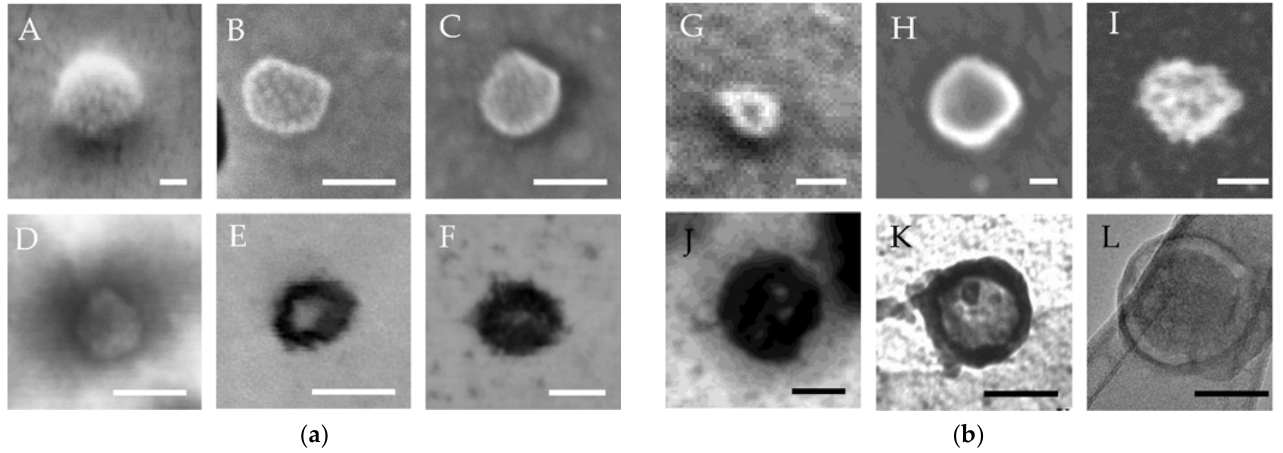
Figure 2. Electron microscopy of EV-like nanoparticles in native CSF ( a ) and EVs isolated by SEC ( b ), imaged in different modes. ( A ): sample fixed with PFA, on Si-wafer, air dried, tilted stage at 45°, SE; ( B ): sample fixed with GA, on polycarbonate membrane, air dried, SE; ( C ): sample fixed with GA, on polycarbonate membrane, dehydrated in ethanol gradient and critical point dried, SE; ( D ): sample fixed with GA, on carbon-formvar grid, uranyl acetate contrasted, air dried, STEM-BF; ( E ): sample fixed with GA, on carbon-formvar grid, Uranyless contrasted, air dried, STEM-BF; ( F ): sample fixed with GA, on carbon-formvar grid, UA-zero contrasted, air dried, STEM-BF; ( G ): sample fixed with PFA, on Si-wafer, air dried, tilted stage at 45°, SE; ( H ): sample fixed with GA, on polycarbonate membrane, dehydrated in ethanol gradient and critical point dried, SE; ( I ): sample fixed with PFA, on carbon-formvar grid, uranyl acetate contrasted, air dried, STEM-DF; ( J ): sample fixed with PFA, on carbon-formvar grid, uranyl acetate contrasted, air dried, STEM-BF; ( K ): sample fixed with PFA, on carbon-formvar grid, uranyl acetate contrasted, air dried, TEM-BF at 120 kV; ( L ): sample fixed with GA, on lacey carbon grid, dehydrated in ethanol gradient and critical point dried, TEM-BF at 200 kV. ( A , G , I , J ): Supra Zeiss 40 (Carl Zeiss AG, Oberkochen, Germany); ( B – F ): JSM 7800F (JEOL Ltd., Tokyo, Japan); ( H ): JSM 7600F (JEOL); ( K ): JEM 1200 EXII (JEOL); ( L ): JEM 2100 (JEOL). EV: extracellular vesicle, CSF: cerebrospinal fluid, SEC: size-exclusion chromatography, PFA: paraformaldehyde, GA: glutaraldehyde, SE: scanning electron microscope—secondary electron detector, STEM-DF: scanning electron microscope—dark field detector, STEM-BF: scanning electron microscope—bright field detector, TEM-BF: transmission electron microscope—bright field detector. Scale bars represent 50 nm length in all